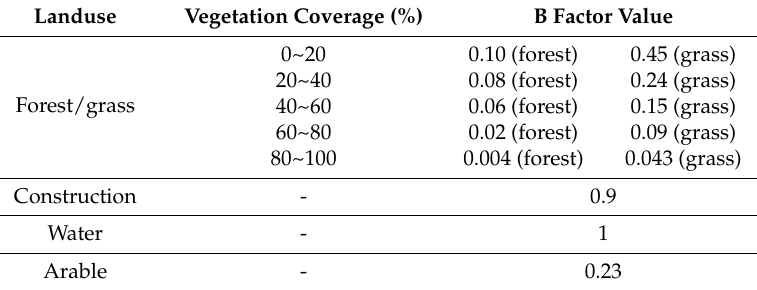
Table 2. B factor values for different land-use and vegetation cover